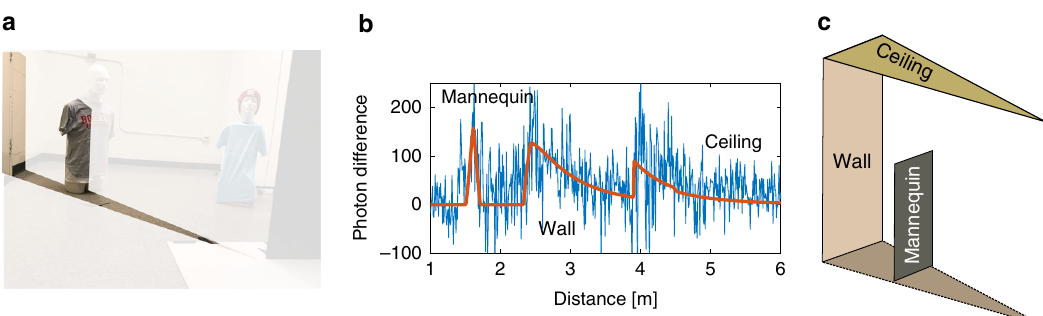
Fig. 3 Reconstruction of a hidden wedge. a A photograph of an example hidden scene, highlighting the wedge to be reconstructed. b The proposed algorithm fi ts the planar facet model (orange) to the acquired histogram difference (blue), identifying contributions from the mannequin, wall, and ceiling. The time to each surface yields the position of the facets, the response shape provides information about the height and orientation, and the amplitude of the response is proportional to the surface albedo. c This information is used to form a 2.5 D reconstruction of the hidden